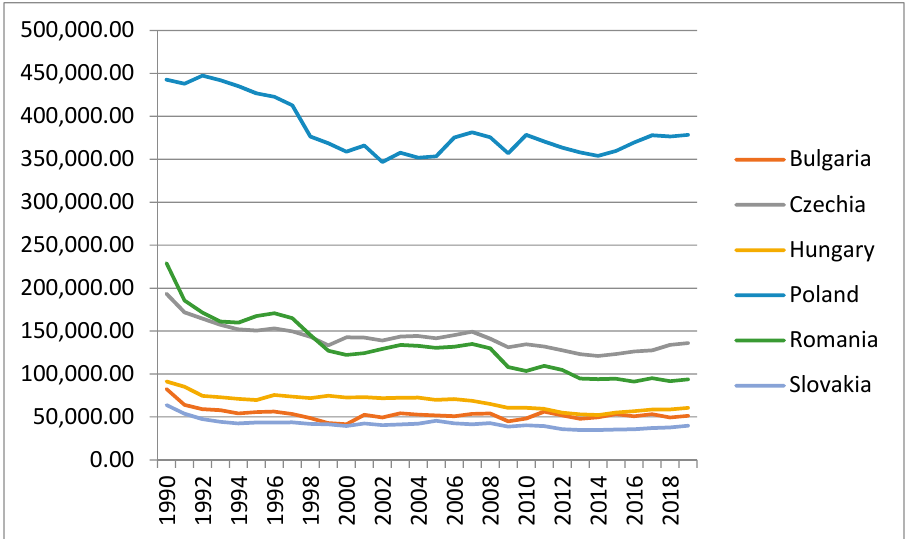
Figure 1. The evolution of the GHG emissions in the analyzed countries (1990–2019). Source: own graph based on Eurostat data